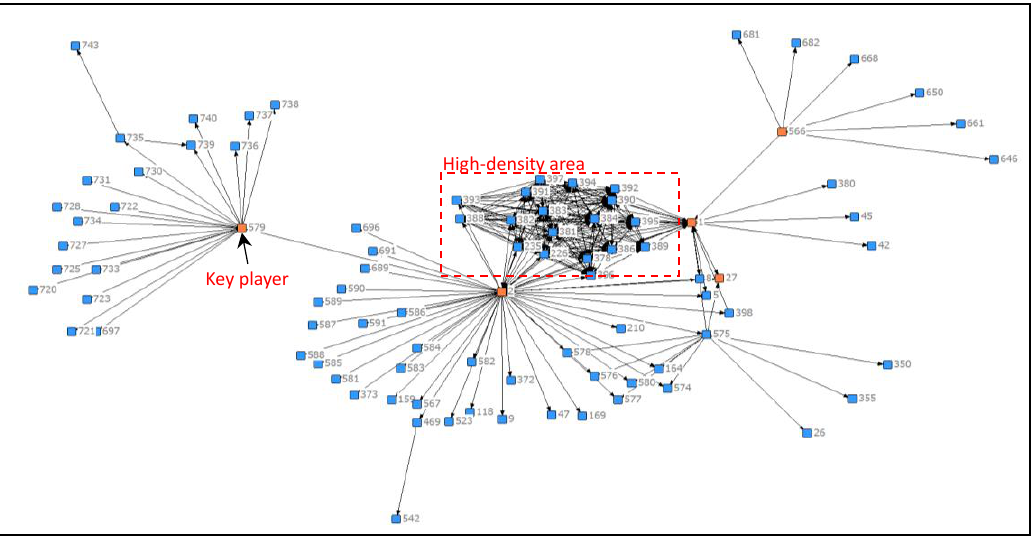
Figure 9. Threshold-five network interaction on the